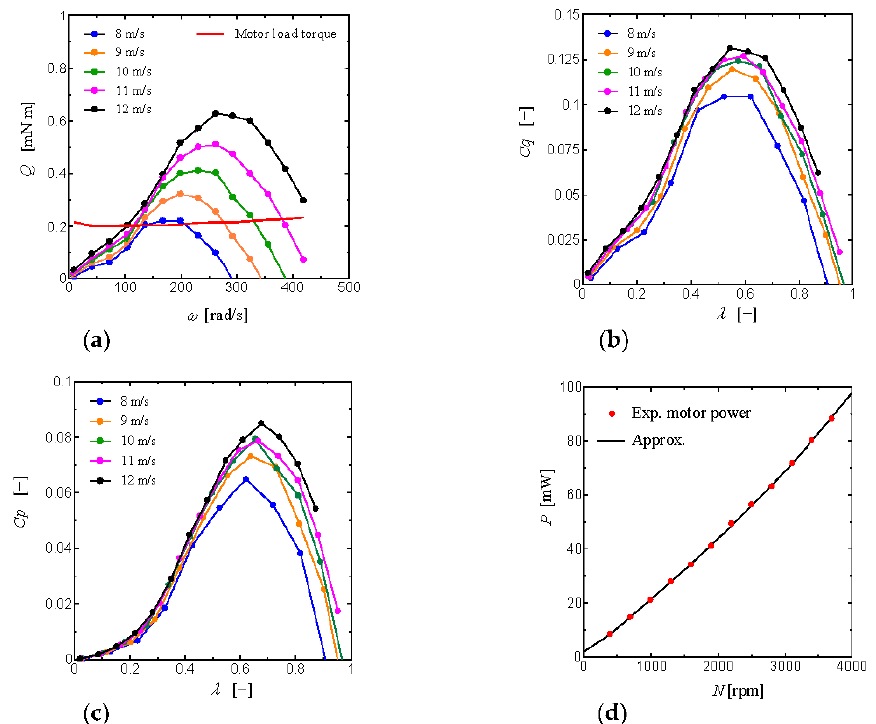
Figure 3. Experimental data of a 3-D-printed miniature rotor measured in Tottori University: ( a ) torque characteristics of the wind turbine and motor load torque; ( b ) torque coefficient; ( c ) power coefficient; ( d ) power as a function of rotational speed.